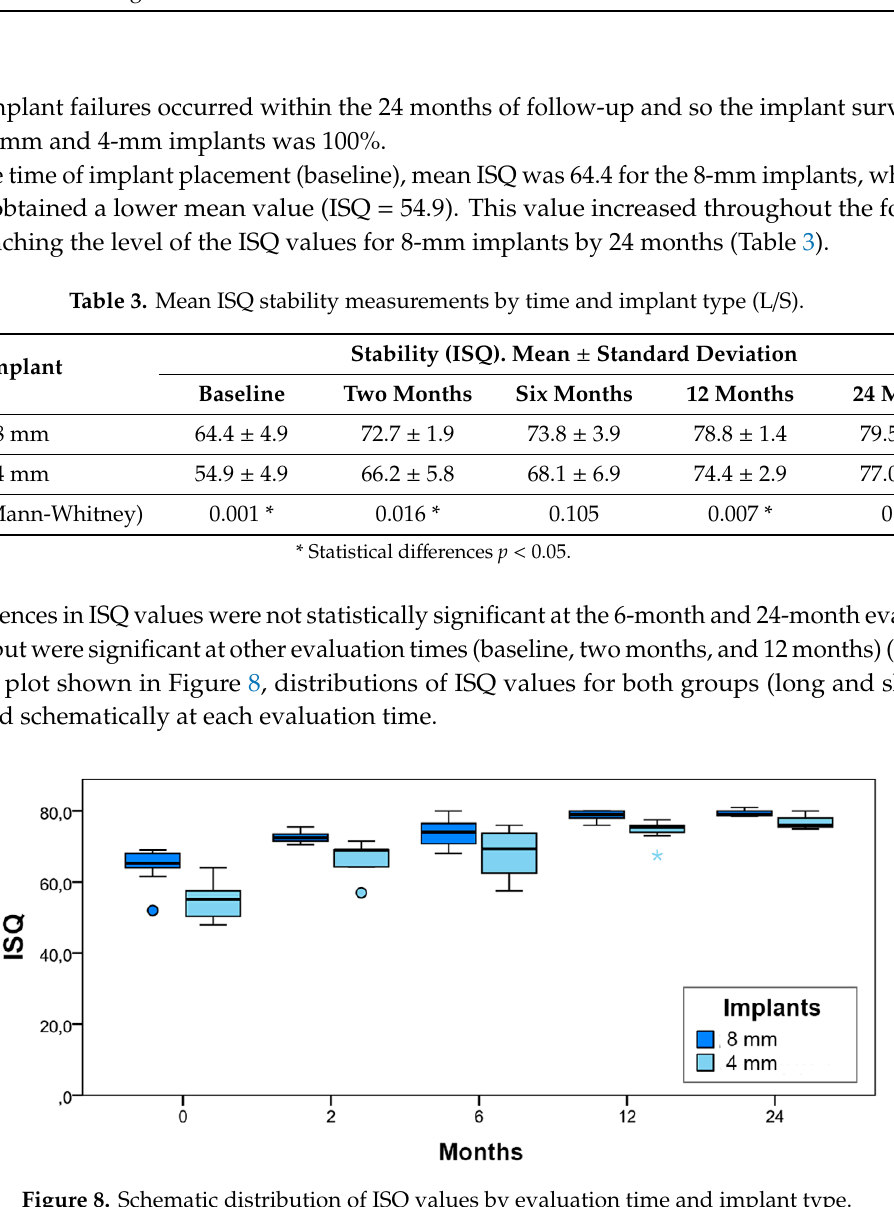
Figure 8. Schematic distribution of ISQ values by evaluation time and implant type.